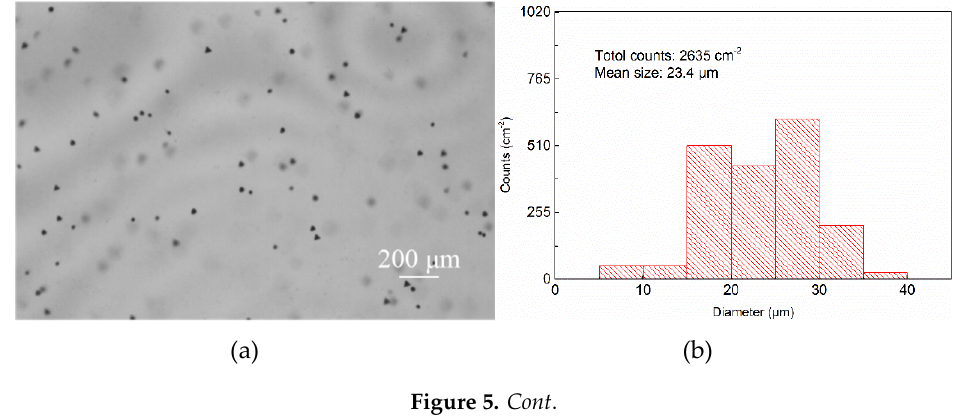
Figure 4. Crystallinity of CZT3: ( a ) X-ray rocking curve and ( b ) IR transmittance.